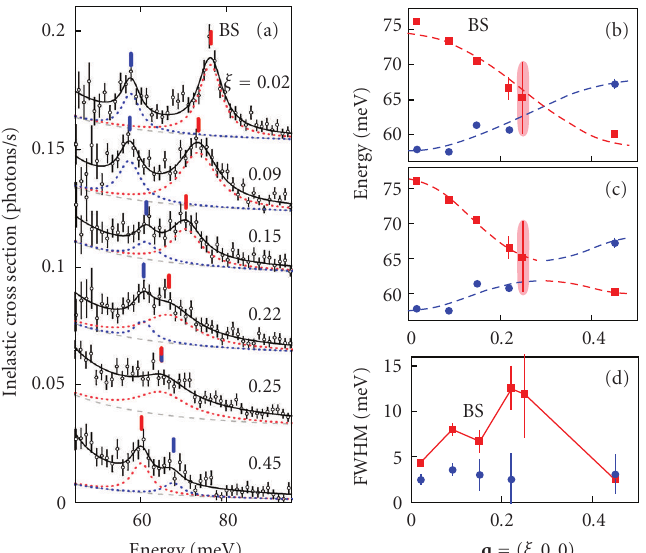
Figure 27: LO phonon dispersions in Bi 2 Sr 1 . 6 La 0 . 4 Cu 2 O 6+ x [78]. (a) IXS spectra for Q = (3+ ξ ,0,0) with ξ from the BZ center (top spectrum, ξ = 0.02) to the BZ boundary (bottom spectrum, ξ = 0.45). The spectra are vertically shifted. The solid lines show the harmonic oscillator fit, the dashed lines show the elastic tail and the dotted lines show the two modes used in the fit. (b,c) Phonon dispersions and linewidths. The cosine dashed lines are guides for the eye illustrating the crossing (b) and anticrossing (c) scenarios. (d) Full width at half maximum. The error bars are an estimate of the standard deviation of the fit coe ffi cients.